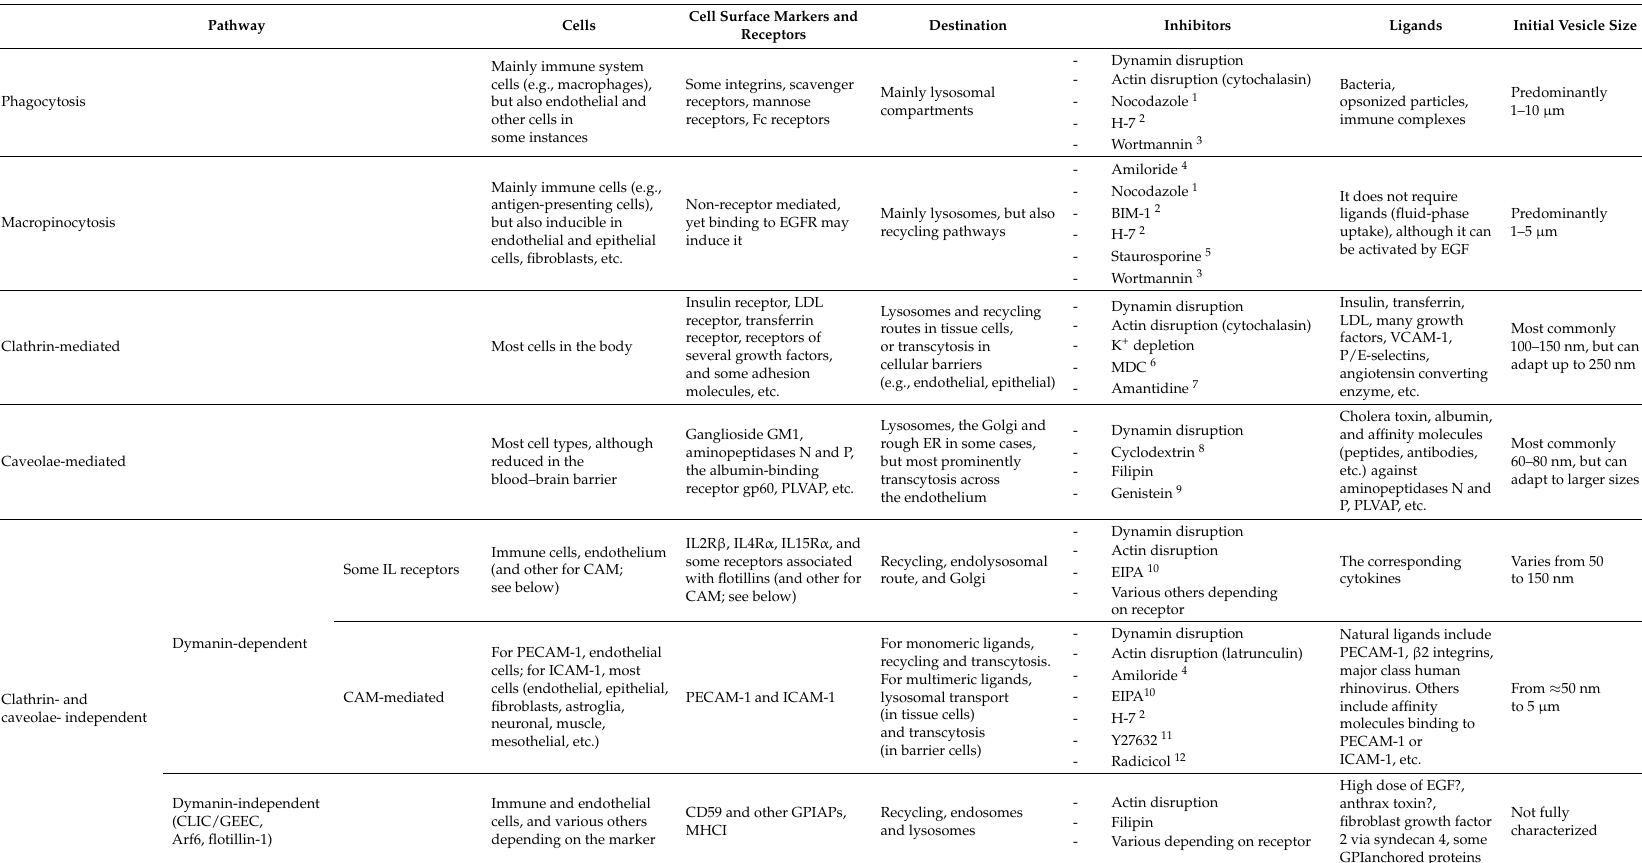
Table 1. Endocytic vesicular transport